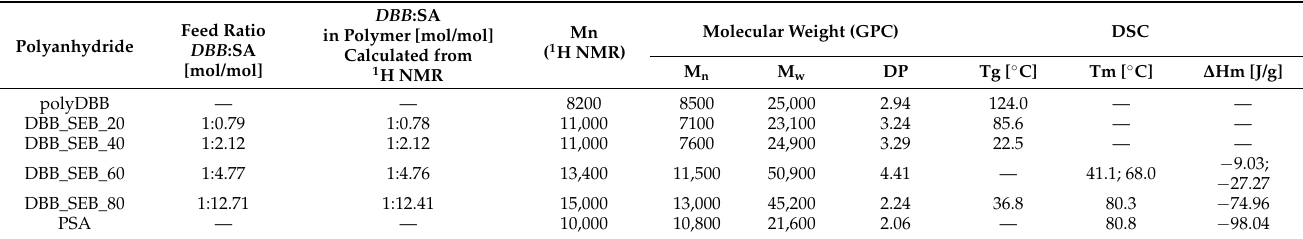
Table 3. Characteristics of DBB-SEB polyanhydrides.